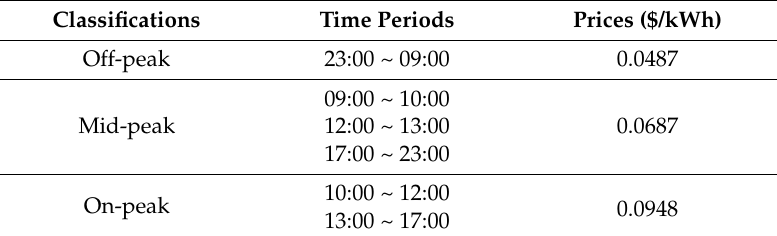
Table 4. Considered TOU